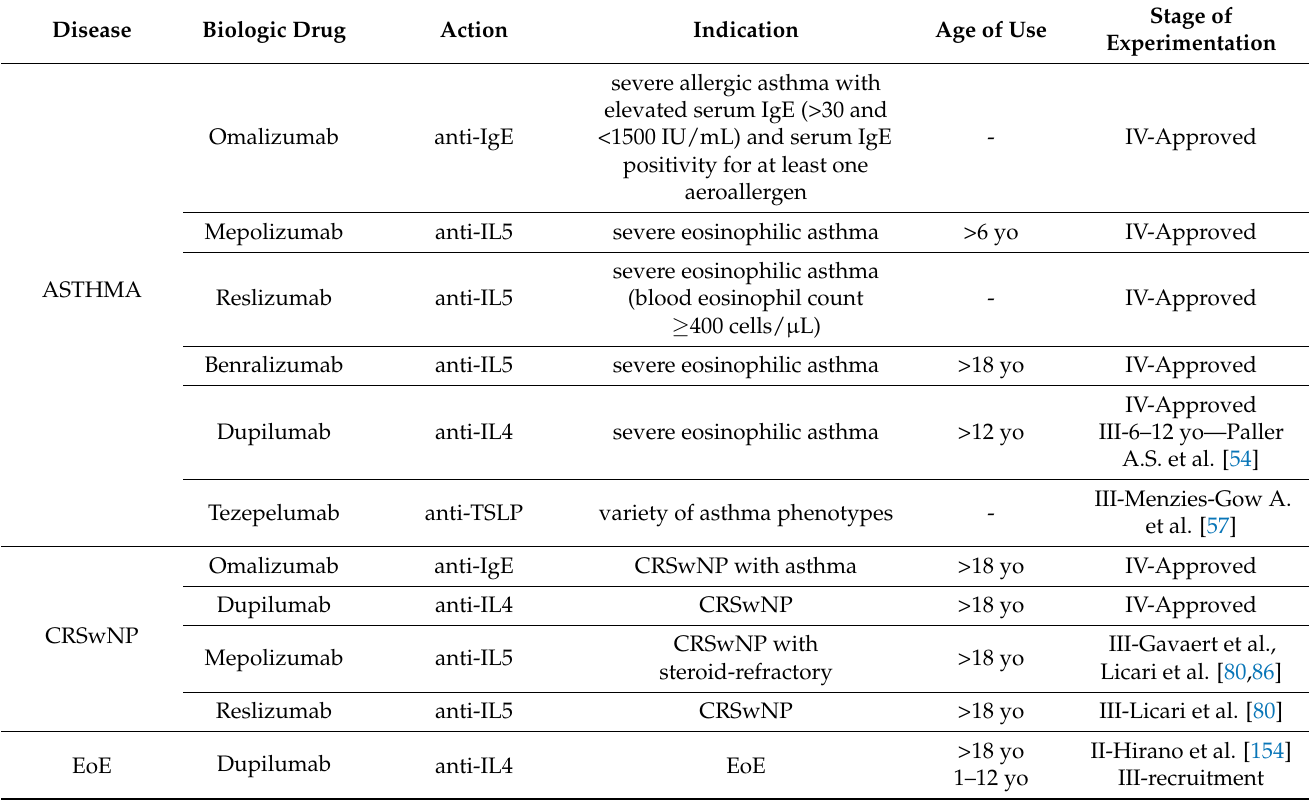
Table 1. Biologic treatment in atopic dermatitis (AD), asthma, chronic rhinosinusitis with nasal polyps (CRSwNP), or eosinophilic esophagitis (EoE).